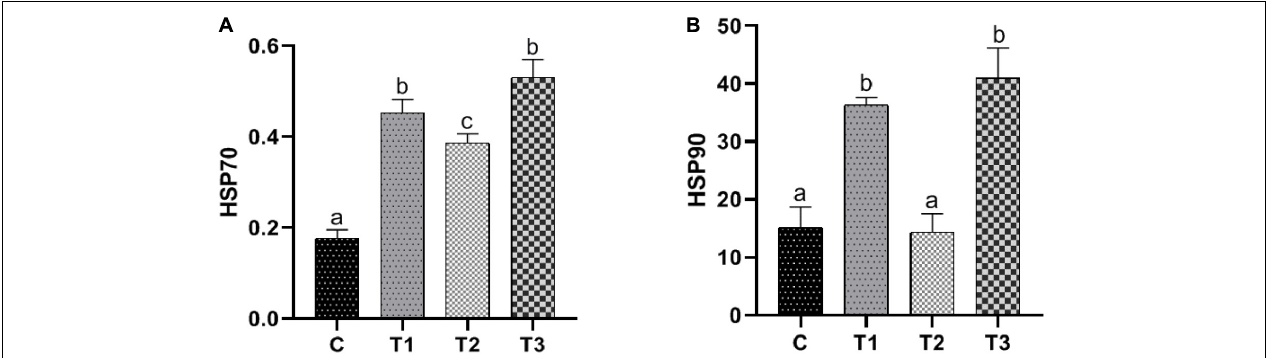
FIGURE 2 | Effect of temperature variation on gene expression of heat shock protein 70 and 90 in the liver of large yellow croaker. (A,B) Represents gene expression of heat shock protein 70 and 90 in the liver of large yellow croaker. Columns with different letters are significantly different ( P < 0.05). C represents the control group where the fish were kept at 12 ◦ C since the beginning of the experiment; T1 represents the group sampled on the first day when the water temperature reached 8 from 12 ◦ C; T2 represents the group sampled after the fish were kept at 8 for 3 days, and T3 represents the group sampled after the water was heated to 12 ◦ C from 8 ◦ C. The data are presented as the mean ± SD ( n =